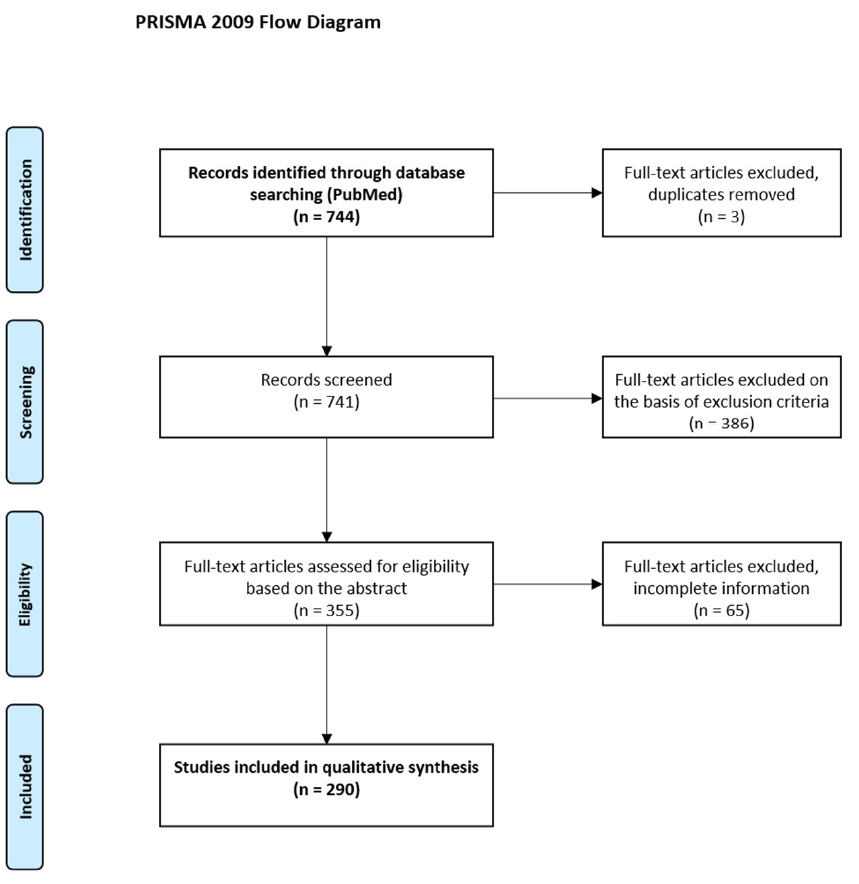
Figure 2. Preferred Reporting Items for Systematic Reviews and Meta-Analyses flow diagram.